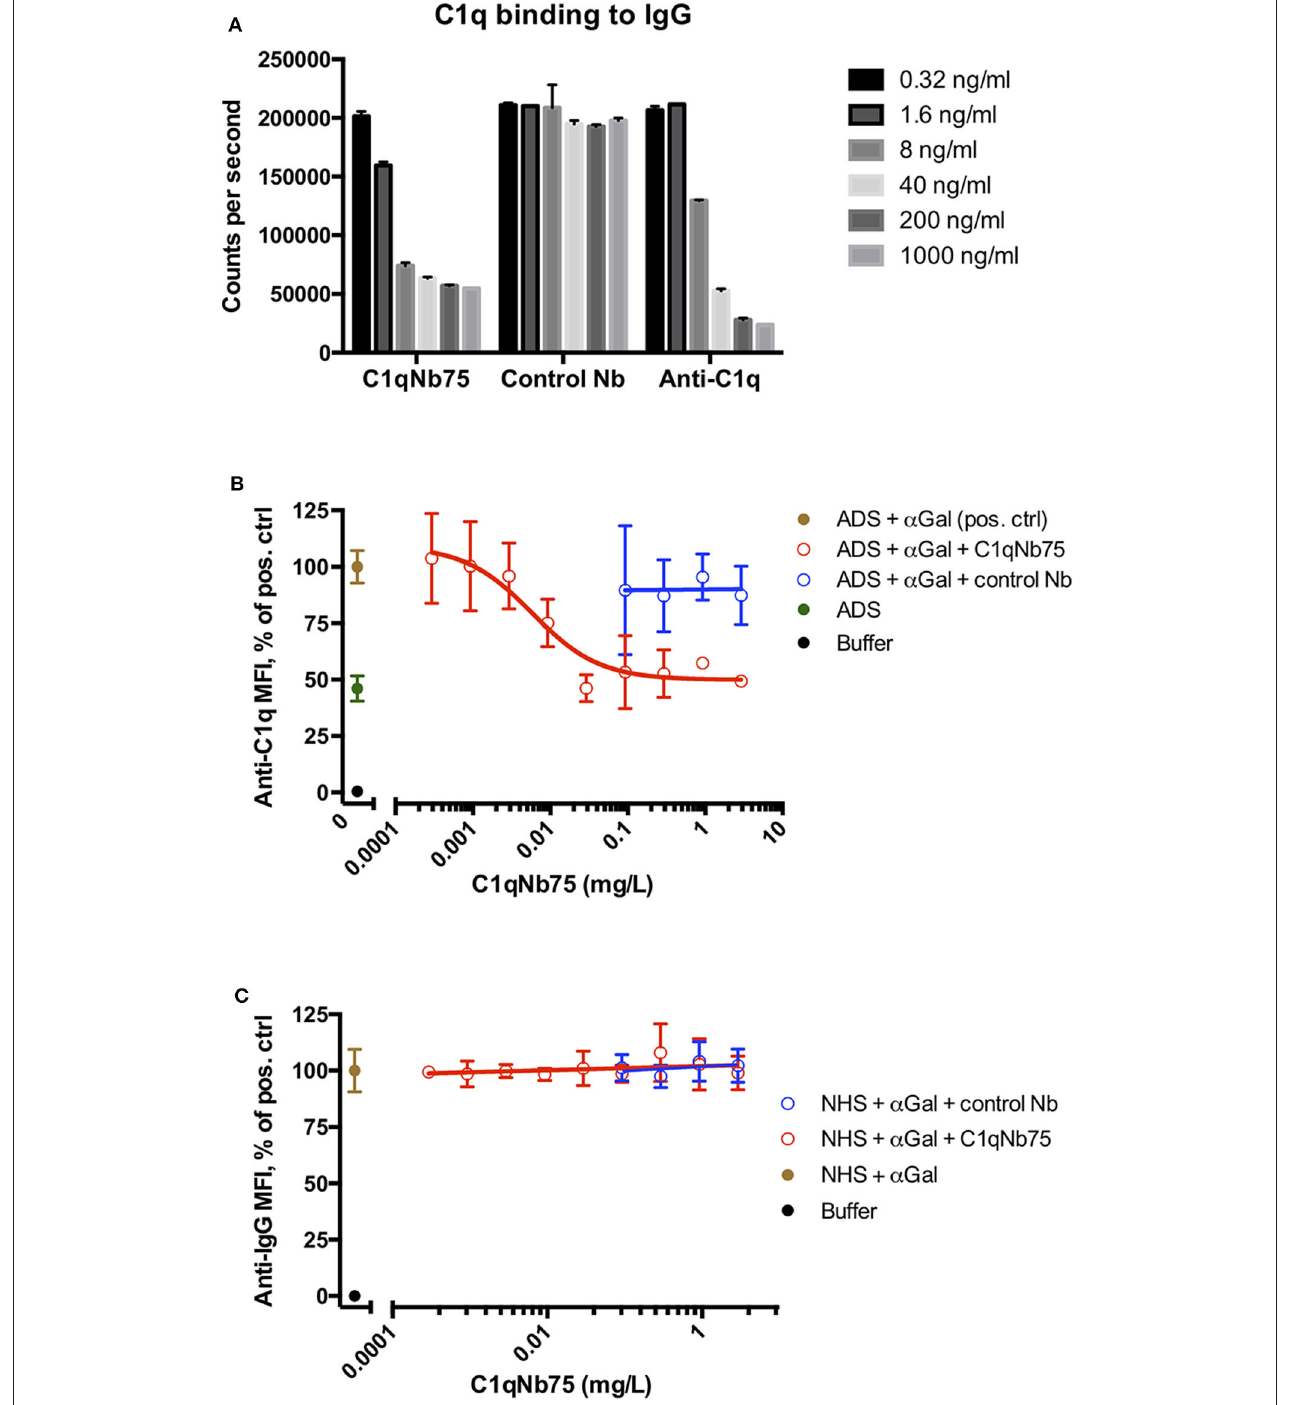
FIGURE 2 | C1qNb75 interferes with binding of C1q to surface bound IgG. (A) Binding of C1q to IgG in microtiter wells in the presence of the indicated contractions of C1qNb75, control Nb or anti-C1q antibody. (B) Binding of C1q (in ADS) to antibody sensitized pig red blood cells in the presence of C1qNb75 or control Nb. C1q binding was detected by flow cytometry using a polyclonal fluorescently labeled anti-C1q antibody and plotted as % of mean fluorescence intensity (MFI) of a positive control with SD. Results are representative of two independent experiments. (C) Same experiments as in panel (B) , but where binding of IgG was measured with flow cytometry using fluorescently labeled